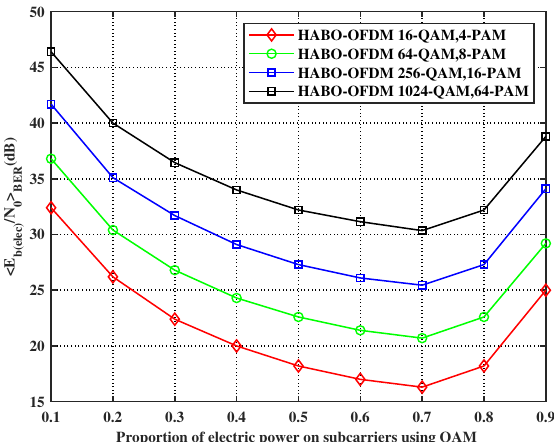
Figure 7. Comparison of (cid:104) E b ( elec ) / N 0 (cid:105) BER for HABO-OFDM for different proportions of elec- tric